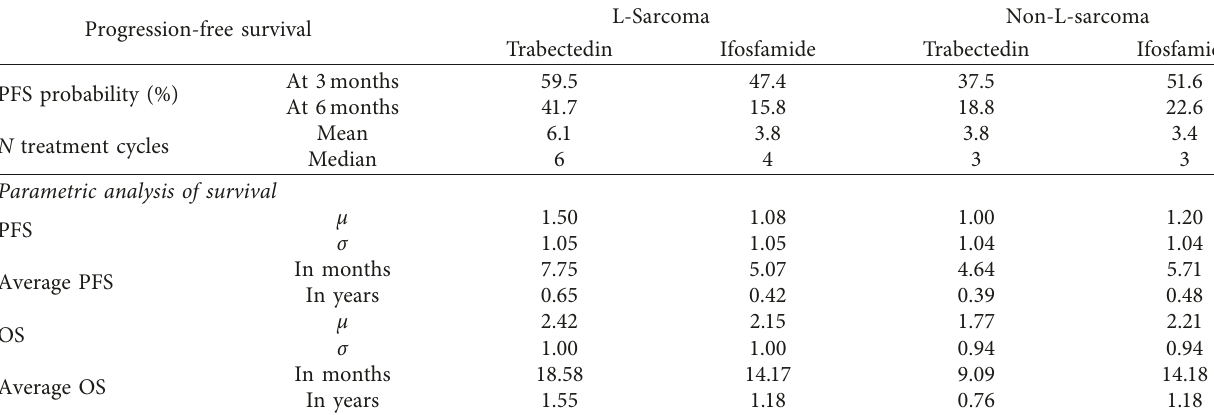
Table 2: Progression-free survival rate age at 3 and at 6 months, the mean and median number of treatment cycles received, the parametric description of survival with the lognormal distribution, and average survival times. The estimated average survival time with the lognormal distribution is calculated by exp ( μ + σ 2